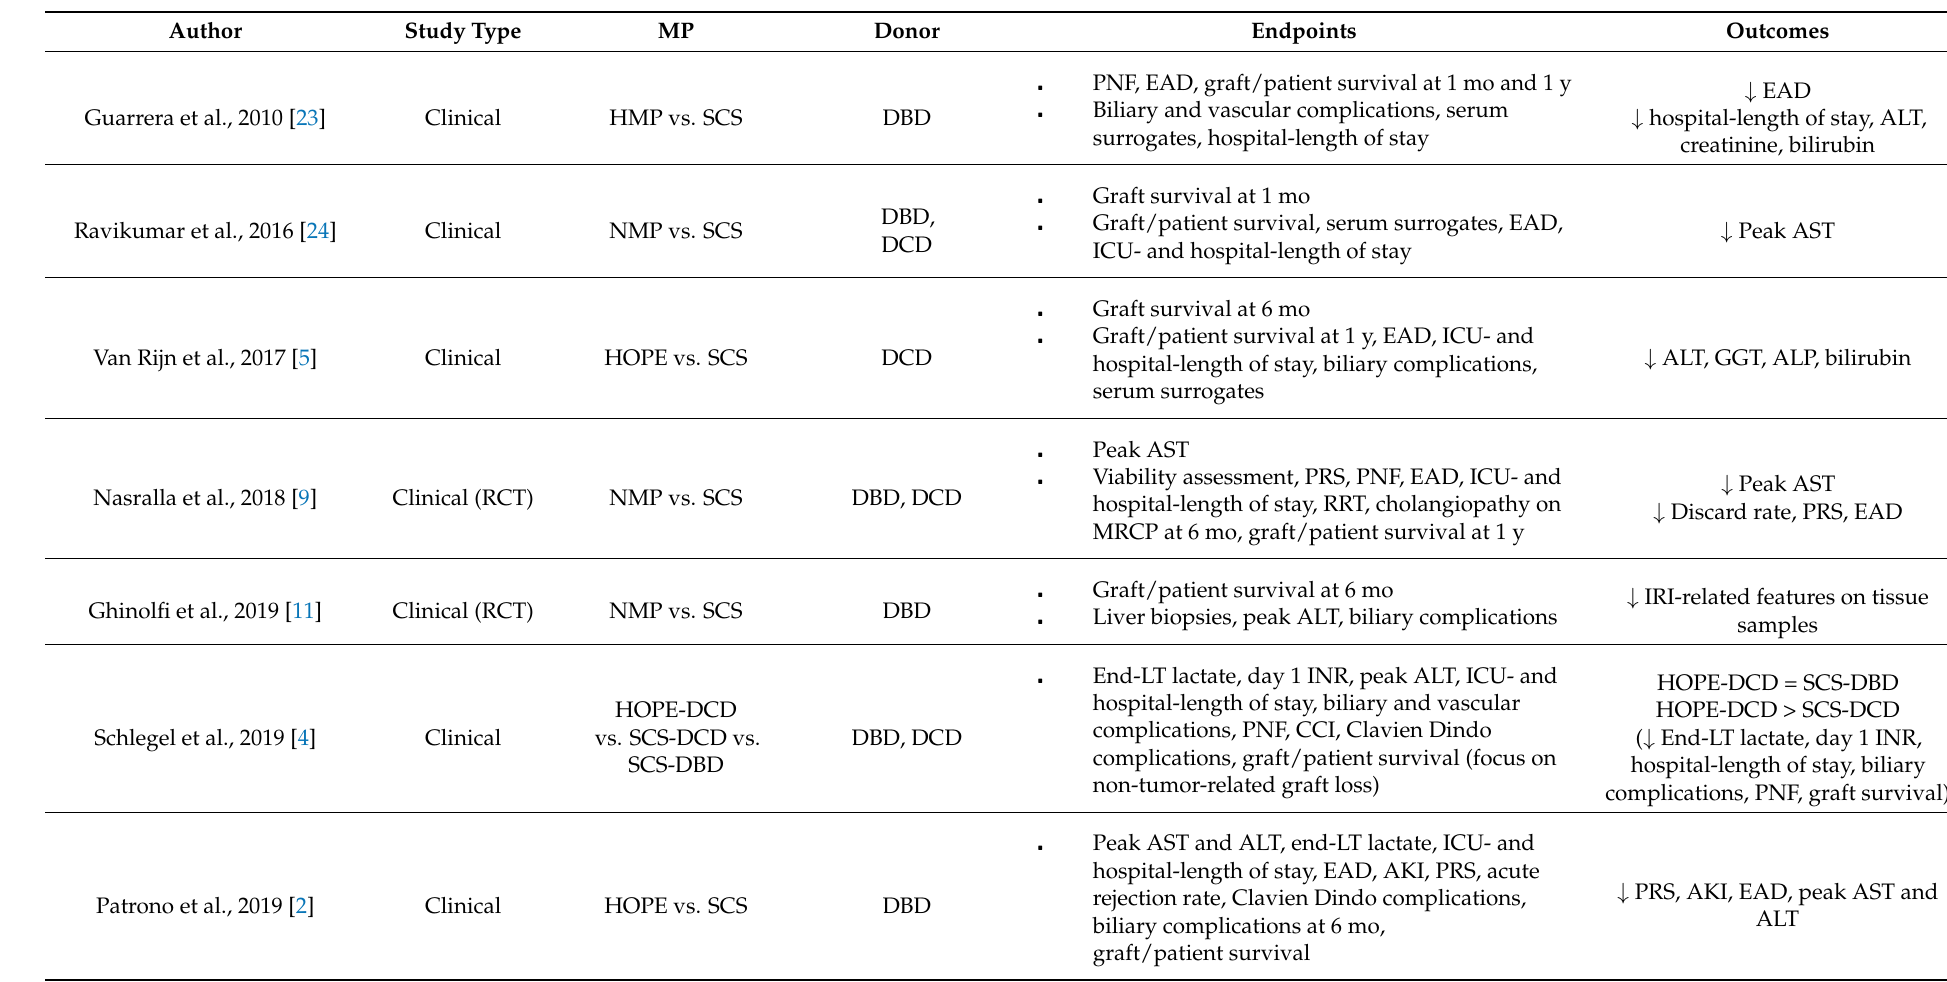
Table 1. Clinical studies involving MP technology in